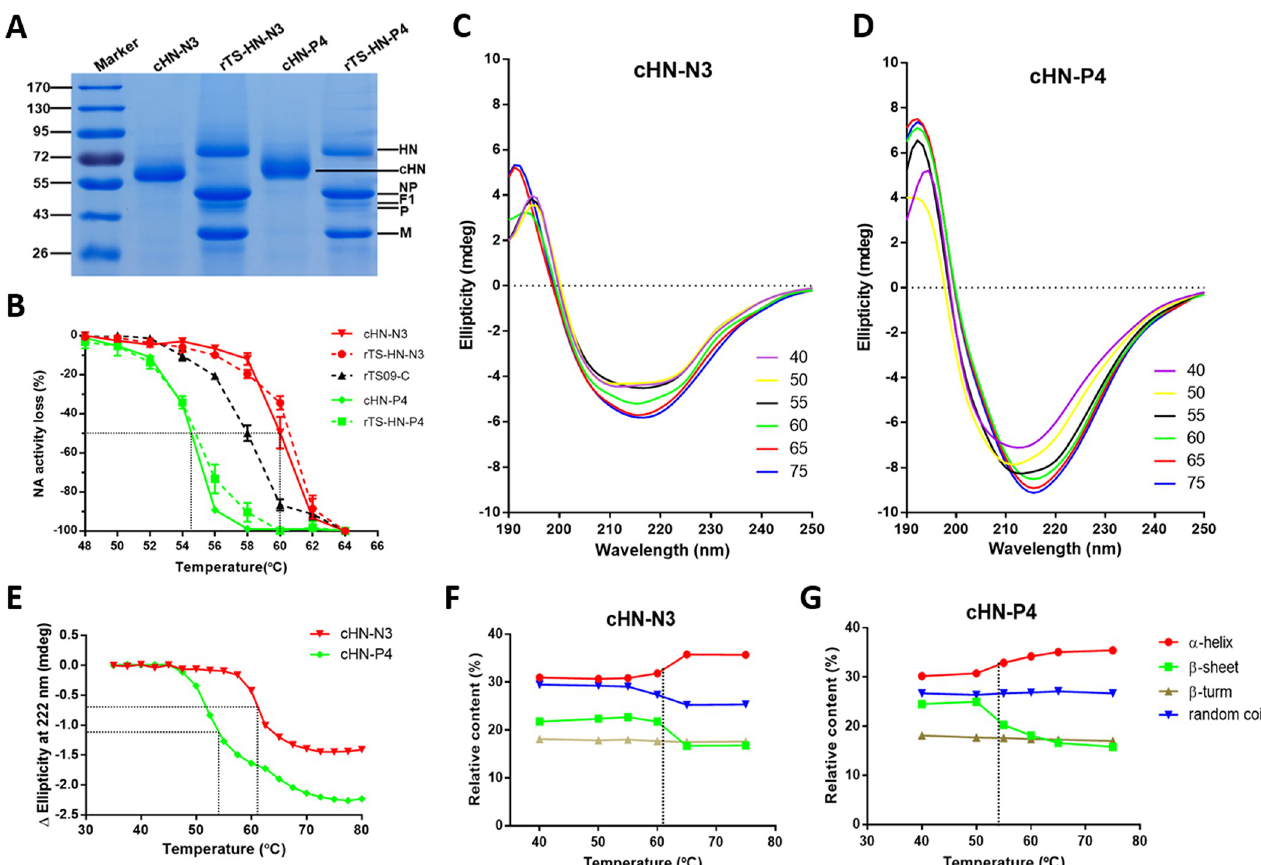
Fig 4. Effect of the surface charge of HN protein on its structural stability. (A) SDS-PAGE analysis of HN proteins cleaved from viral particles of NDV rTS-HN-N3 and rTS-HN-P4. (B) Heat-inactivation kinetics of NA activity of cHN proteins and NDV mutants. After heat-treatment at the indicated temperature for 10 min, the proteins and viruses are tested for their NA activity. The inactivated fractions of NA activity are represented on a percent scale as a function of heat-treatment temperature. The stability of protein/virus is shown as the temperature for a 50% decrease in NA activity of protein/virus heat- treated for 10 min (T m-NA ). (C, D) Far UV CD thermal unfolding profiles of protein cHN-N3 (C) and cHN-P4 (D). The CD spectra at different temperature ranging from 40˚C (purple) to 75˚C (blue) are measured using a CD spectrophotometer J-1500 (JASCO). The legend on the right shows the line colors and their corresponding temperatures. (E) Temperature-induced transition of HN proteins as monitored by the changes in ellipticity at 222 nm. The protein stability is shown as the temperature for a 50% decrease in Δ Ellipticity at 222 nm (T m-CD ). (F, G) Secondary structure contents of protein cHN-N3 (F) and cHN-P4 (G) under different heat-treatment